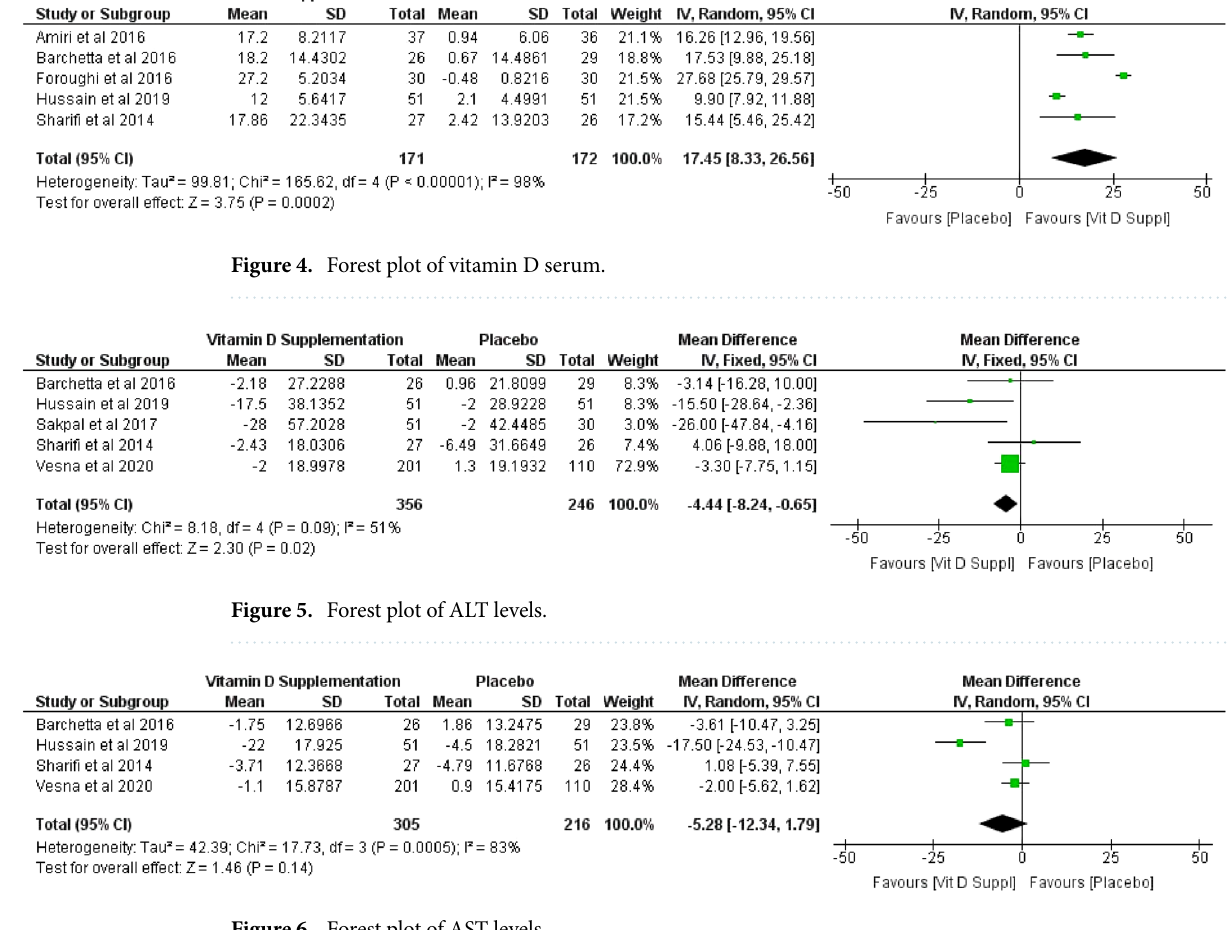
Figure 6. Forest plot of AST levels. Covariate Coefficient SE 95%